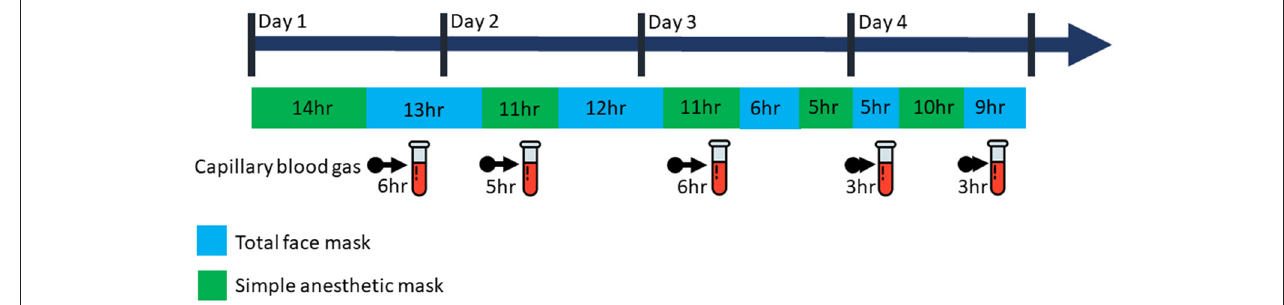
FIGURE 3 | Timeline of switches between NIV interfaces. Timeline for the relatively stable four-day period (relating to Table 1 ) showing the frequency of switches between the total face mask and simple anesthetic mask, as per decision of the attending nurse and/or physician (approximate time in hours spend on each mask as indicated in the figure). Switches between masks was timed with moments of patient (airway) care and sleep/awake cycles as much as possible. In addition, decision to switch masks was based on clinical judgement (e.g., increased respiratory distress, anxiety). To determine patient ventilation, pCO2 values were measured in capillary blood gases, which were taken daily, as per decision of the attending physician and in timing with normal patient care and sleep/awake